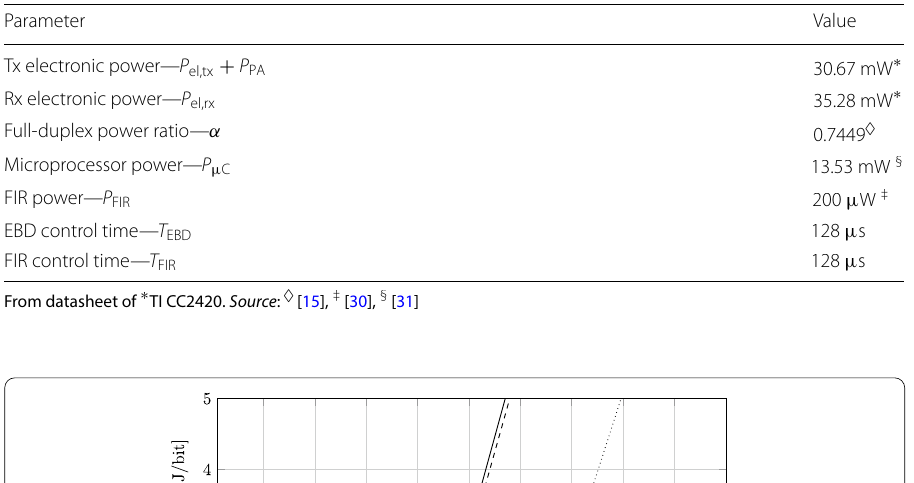
Table 2 Parameters used for numerical evaluations